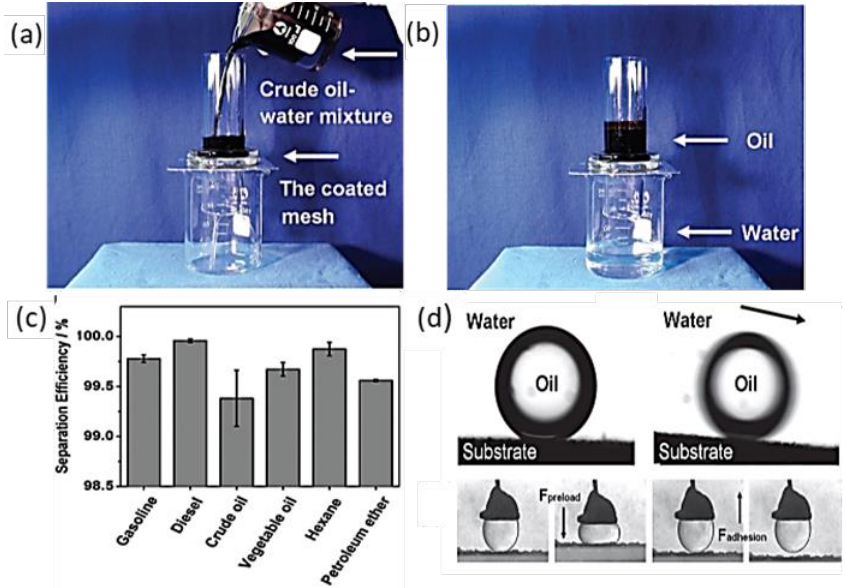
Figure 9. PAM hydrogel-coated mesh oil/water experiments. Mesh pores are 50 µ m. ( a ) Coated mesh was fixed between two glass tubes, and crude oil and water were added to the upper tube. ( b ) Water penetrated the coated mesh whereas oil remained in the upper glass tube. ( c ) The oil rejection coefficient of PAM hydrogel-coated mesh for various oils. ( d ) As-prepared PAM hydrogel-coated mesh demonstrates remarkable wettability with underwater superoleophobic and low oil-adhesion qualities [137]. Reprinted with permission from Ref. [137] Copyright 2011 WILEY-VCH Verlag GmbH & Co. KGaA,